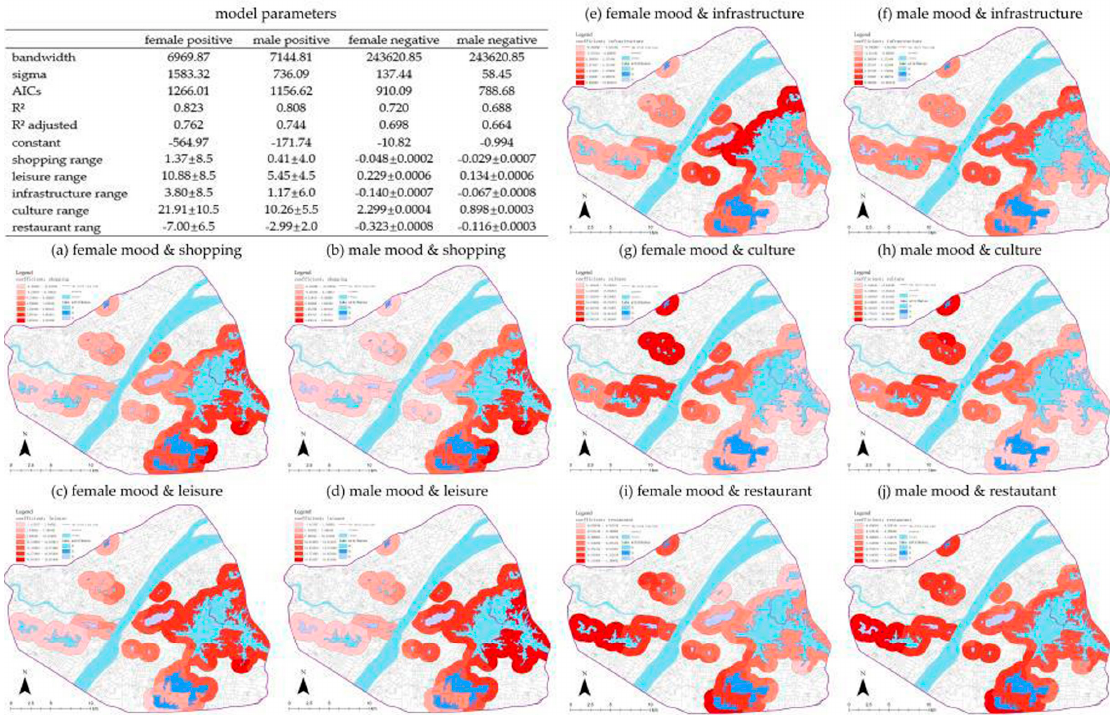
Figure 10. Geographic weighted regression (GWR) positive emotion parameter map ((a)to(j) stand for the GWR relationship between mood value and POIs over different